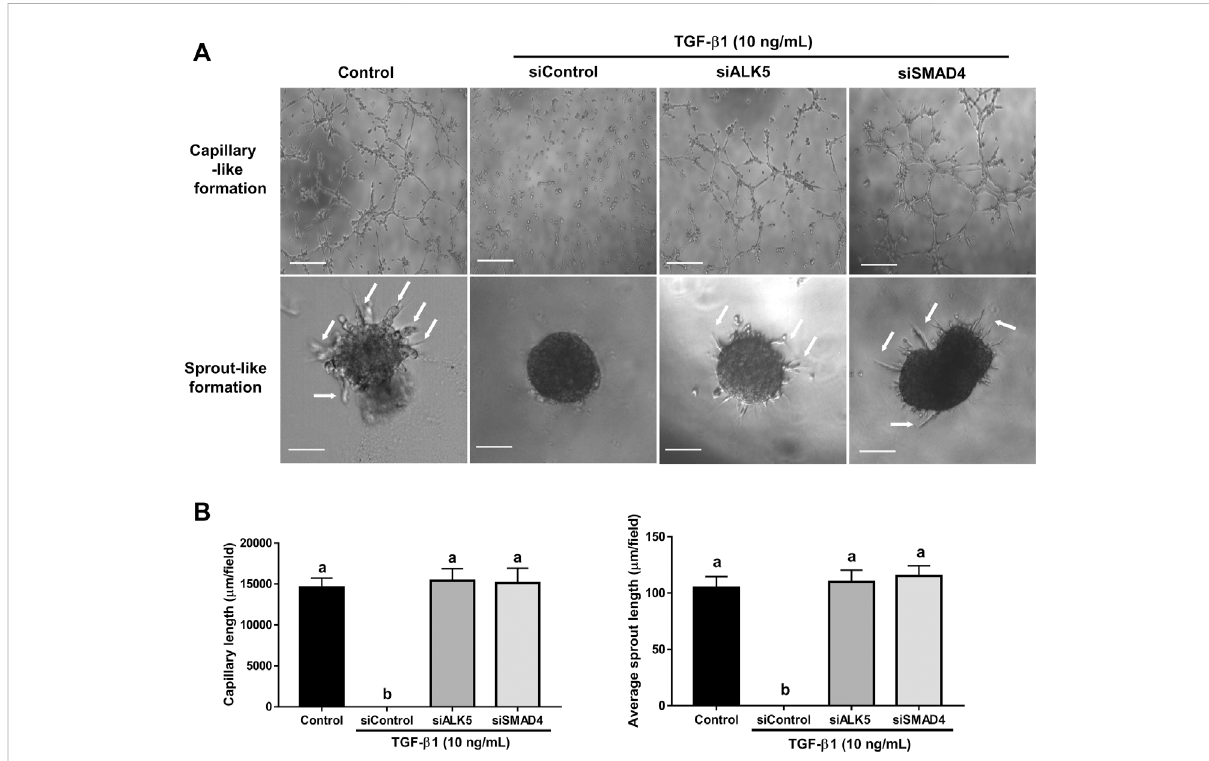
FIGURE 10 Effects of targeted depletion of ALK5 and SMAD4 on the TGF- β 1-induced disturbance in microvasculature-like formation in SVOG cells. (A) Cells were transfected with siControl, siALK5 or siSMAD4 for 24 h and treated for further 24 h with or without TGF- β 1 (10 ng/ml). Finally, cells were transferredtoMatrigelforanadditional5 h(forcapillary-likeformation)and24 h(forsprout-likeformation).Scalebarsofthecapillary-likeformation and sprout-like formation represent 100 µm and 50 μ m, respectively. (B) The lengths of capillaries and sprouts were quanti fi ed by ImageJ. Different letters above are represent signi fi cantly different ( p < 0.05), n =